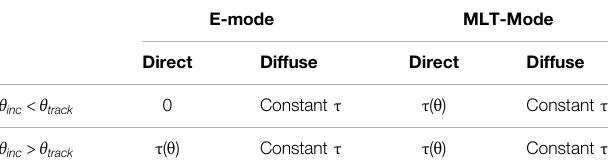
TABLE 2 | Transmittance at different modes.